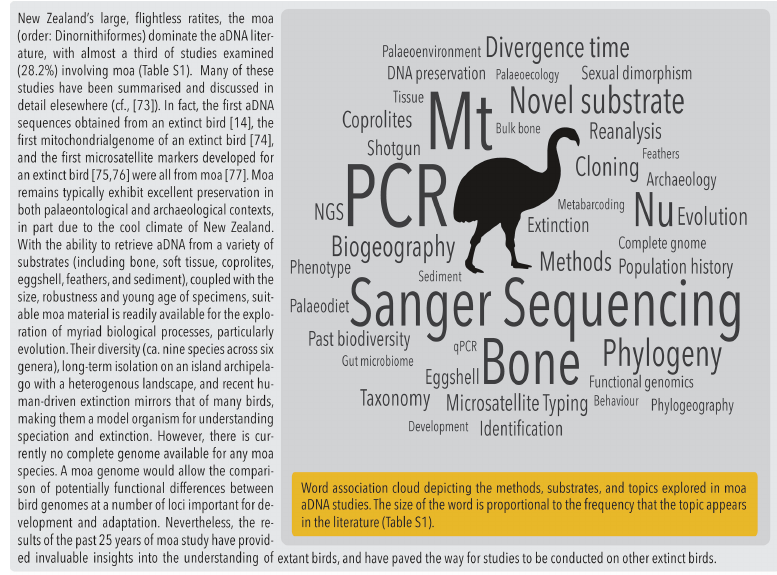
Figure 3. Moa (Dinornithiformes): Extinct model organisms? [14,73–77].